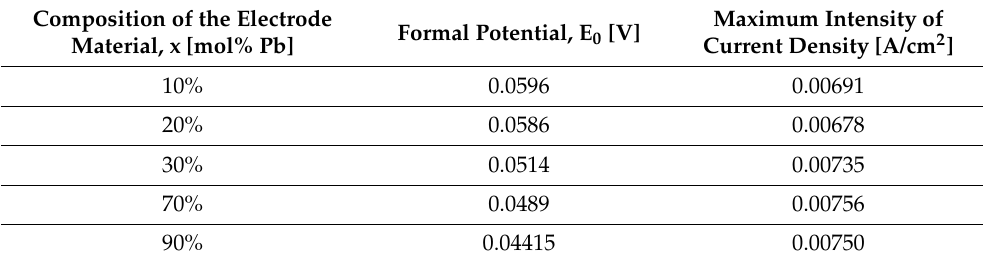
Table 2. Electrochemical parameters corresponding to the linear sweep voltammetric response of the electrode material, namely the formal potential, E 0 , and the maximum current density intensity. Composition of the Electrode Maximum Intensity of Formal Potential, E 0 [V] Material, x [mol% Pb] Current Density [A/cm 2